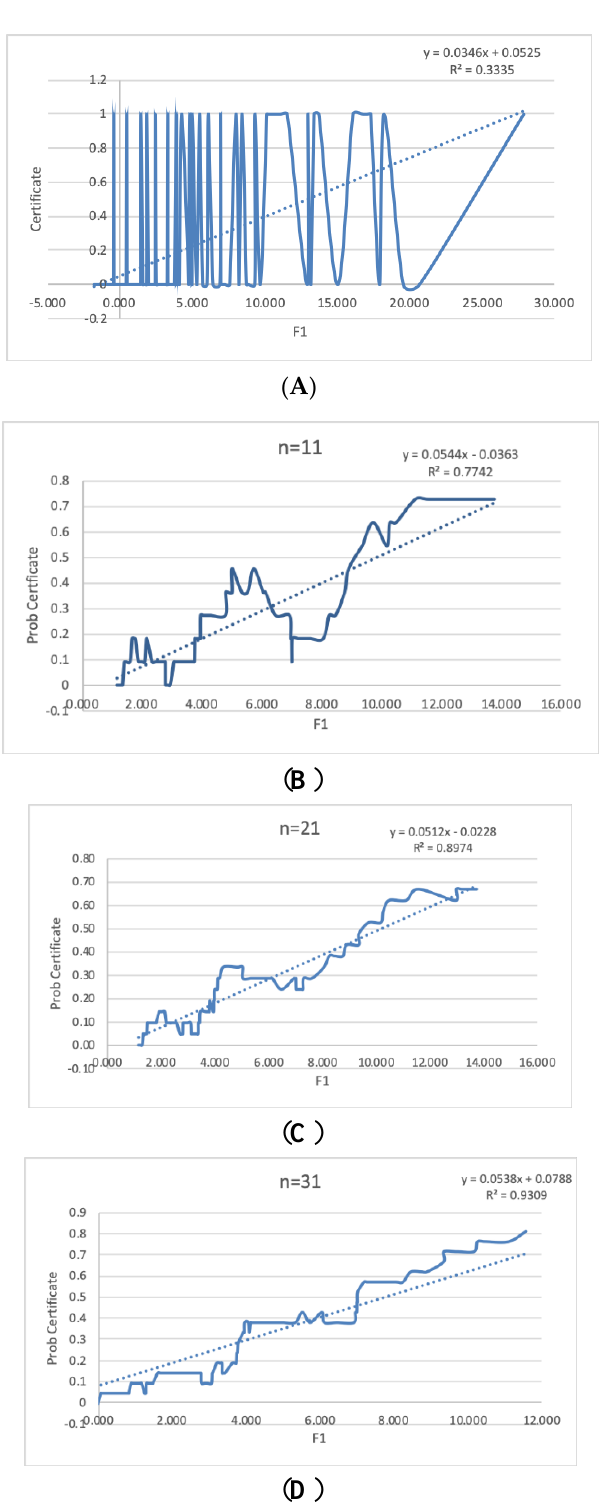
Figure 6. The plot of Certificate probability vs. F1 with the linear fit for the experimental group with different sample sizes (n) of the probability estimate. A -without probability estimate (n = 1), B -with sample size n = 11, C -with sample size n = 21, D -with sample size n = 31